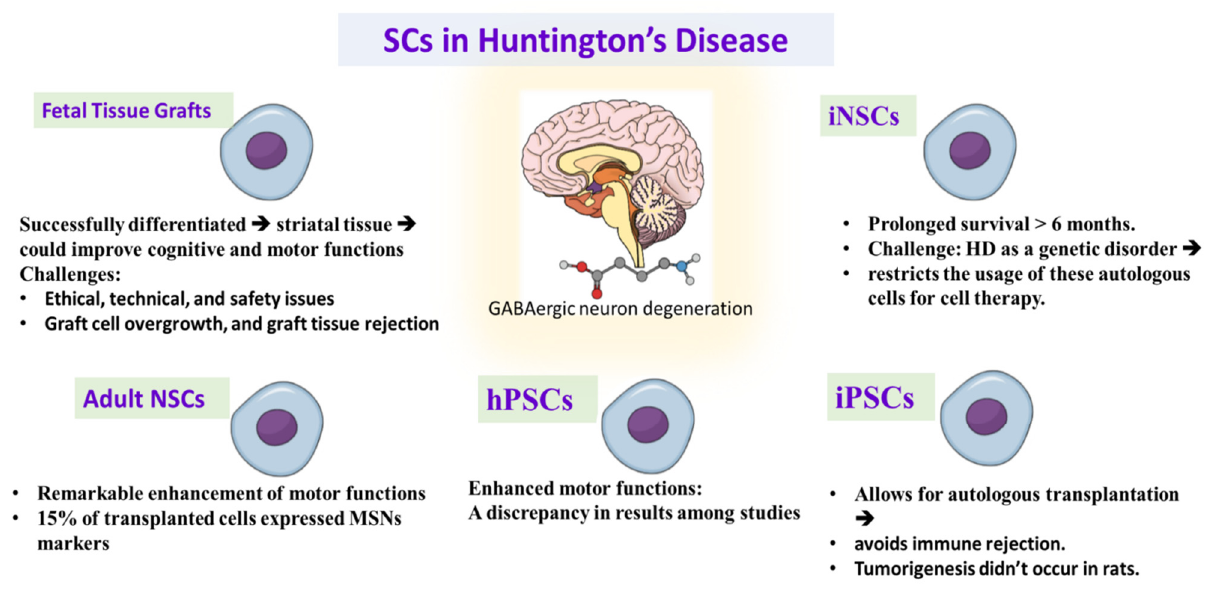
Figure 2. Demonstrating the promising role and challenges of different types of stem cell therapy in treating Huntington’s disease. iNSC: induced neuronal stem cells, iPSCs: induced pluripotent stem cells, hPSCs: human pluripotent stem cells, NSCs: neuronal stem cells, MSNs: striatal medium spiny neurons.